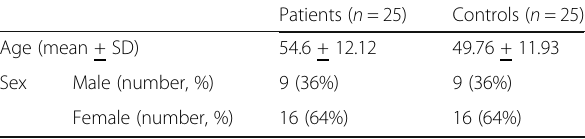
Table 1 Demographic data of diabetic peripheral neuropathy patients and